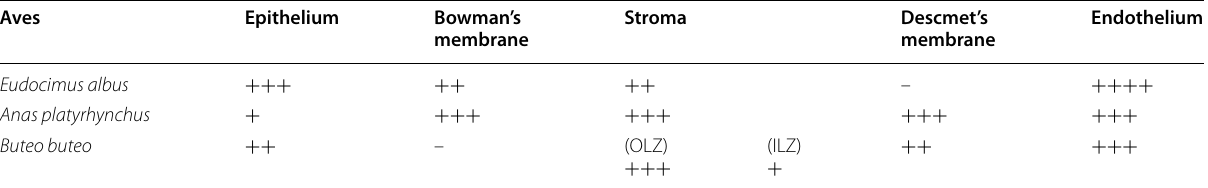
Table 3 Comparison between three investigated avian species according to carbohydrate content in cornea by using Periodic Acid Schiff stain